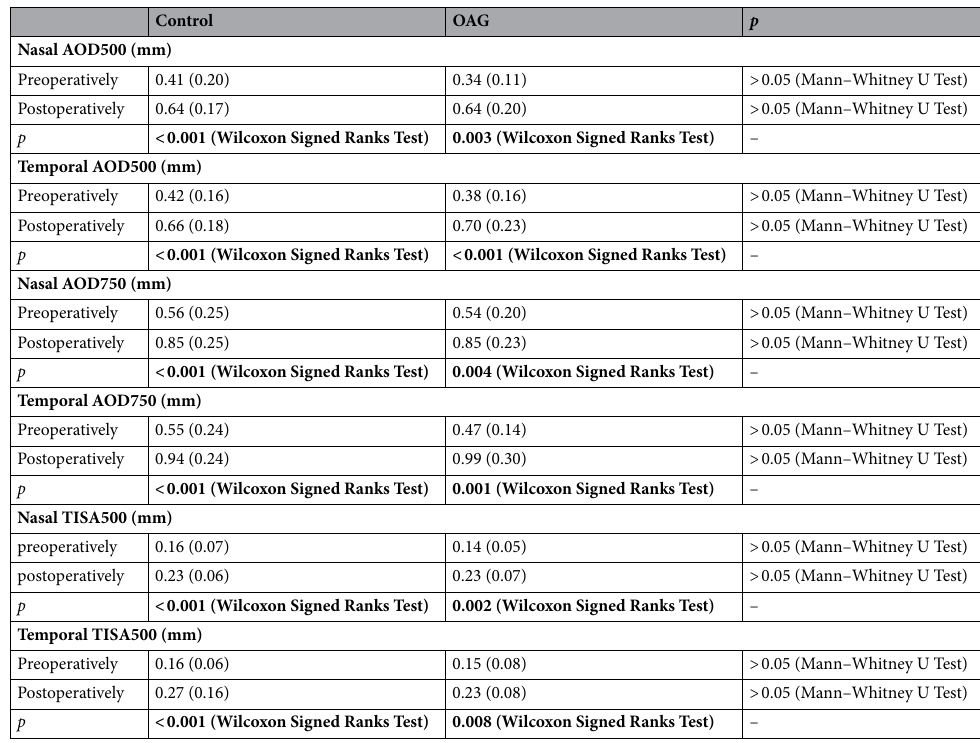
Table 4. ACA parameters pre- and postoperatively (Significance in bold). AOD500, angle opening distance at 500 μm from scleral spur; AOD750, angle opening distance at 750 μm from scleral spur; TISA500, trabecular- iris space area 500 μm from scleral spur. All of the measurements are presented at nasal and temporal quadrants pre- and